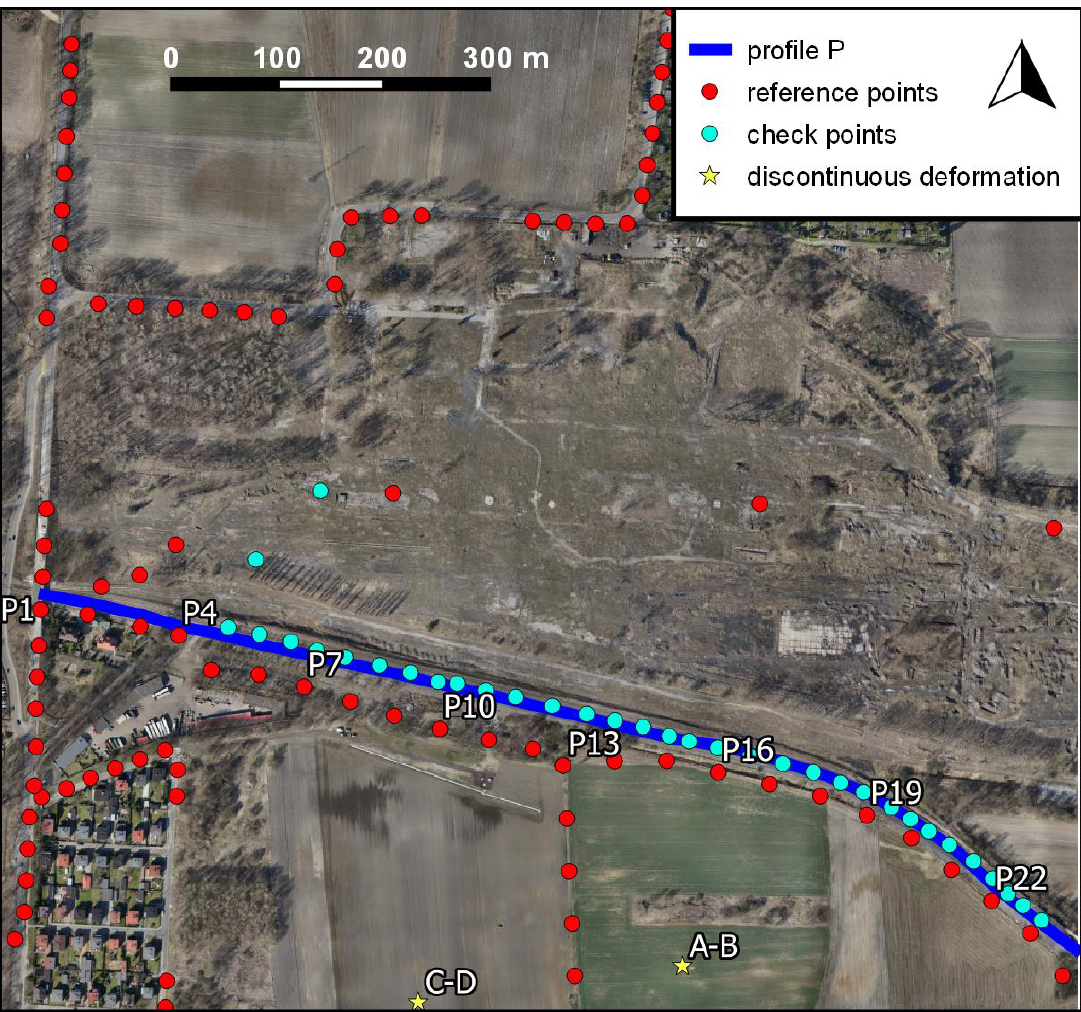
Figure 1. Piekary site: sketch of the observation network against the background of an unmanned aerial vehicle (UAV)-derived orthomosaic.